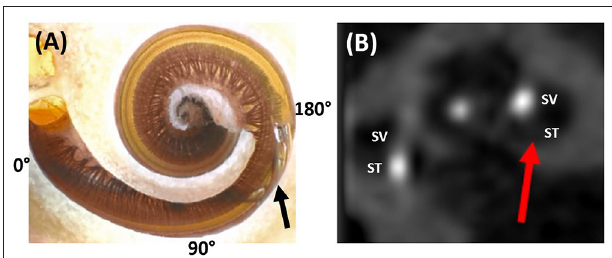
FIGURE 4 | Dissected cochlear sample showing the electrode tip of a pre-shaped electrode penetrating the spiral ligament from the scala tympani (ST) and translocating to scala vestibuli (SV) (A) . Image courtesy of Prof. Peter Roland from Southwestern University, TX, USA. Post-operative CT image slice showing part of the electrode in the SV as pointed by the red arrow (B) . Reproduced by permission of Elsevier B.V (Appendix 2—reference 2).